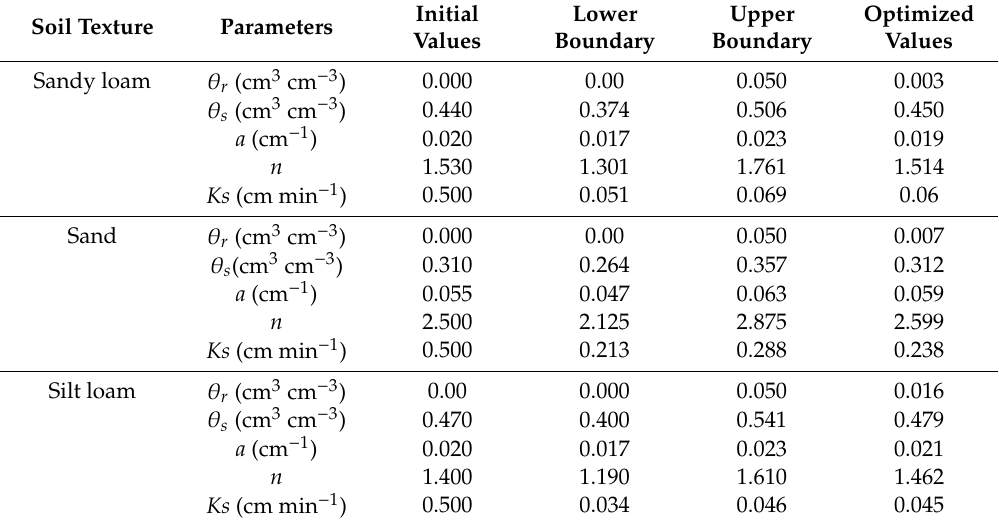
Table 4. Optimized parameters used in PSO and the search space. Residual moisture content ( θ r ), saturation moisture content ( θ s ), a and n the shape parameters of the soil water characteristic curves, and saturated hydraulic conductivity ( Ks